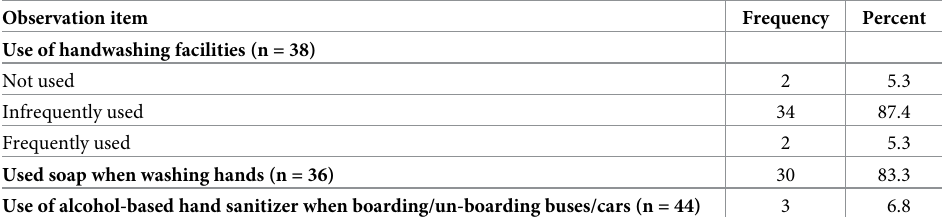
Table 4. Utilisation of handwashing facilities at public transportation stations in the Greater Accra Region. Observation